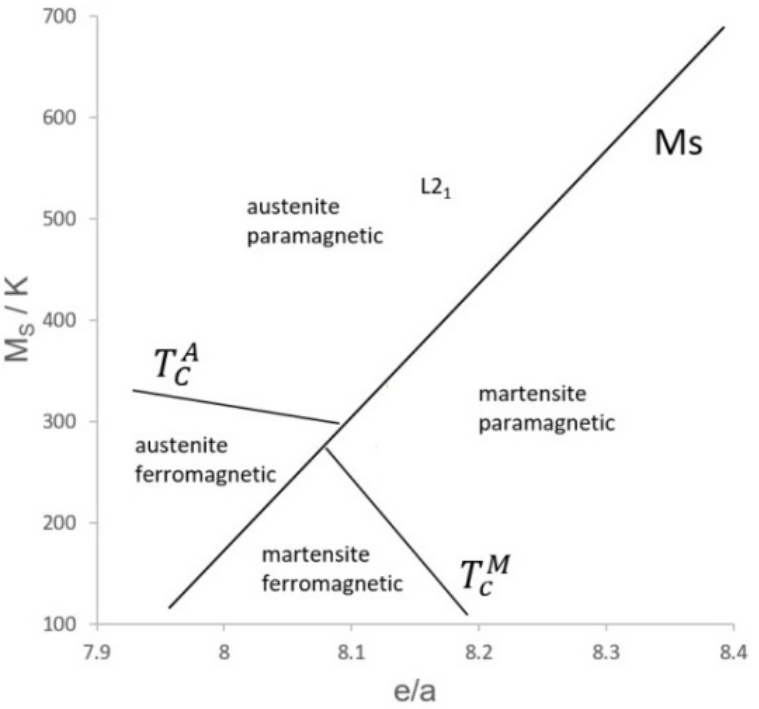
Figure 2. Temperature (martensitic start Ms) transformation diagram topic of Heusler alloys (Reprinted with permission from ref. [44]. Copyright 2022 MDPI).